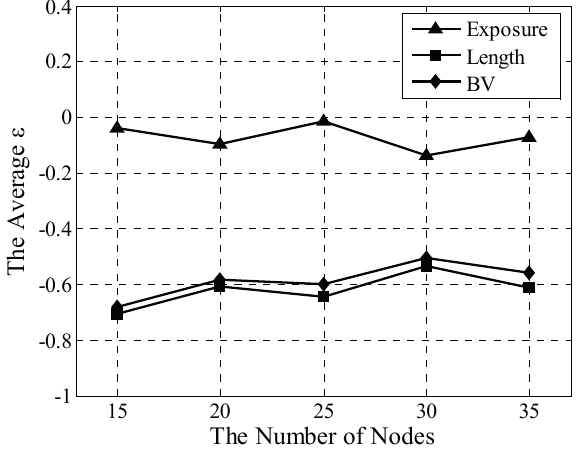
Figure 7. Averaged ε analyses for TES in two-stage heterogeneous network.